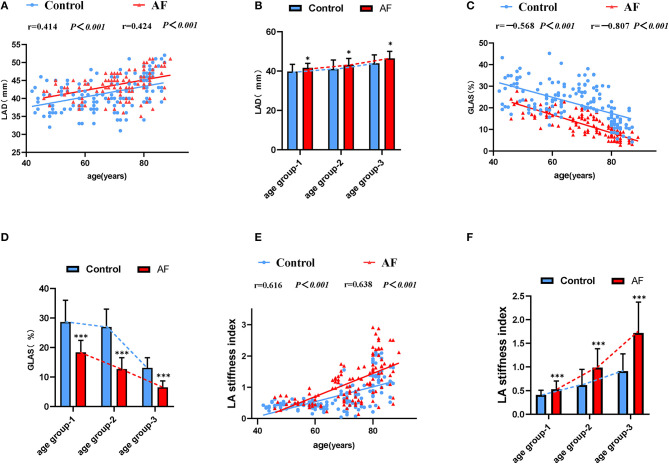
The LA performance in the control individuals and AF patients during physiological aging. (A) Correlations of LAD and age in control adults and AF patients. (B) The effect of AF on LAD during aging. (C) Correlations of GLAS and age in control adults and AF patients. (D) The worse GLAS was shown in AF patients during aging. (E) A strong positive association between LA stiffness index and age. (F) Changes for LA stiffness index in the absence and presence of AF during aging. LAD, left atrial dimension; GLAS, left atrial global longitudinal strain. *P < 0.05 vs. control in age-match groups; **P < 0.01 vs. control in age-match groups; ***P < 0.001 vs. control in age-match groups.